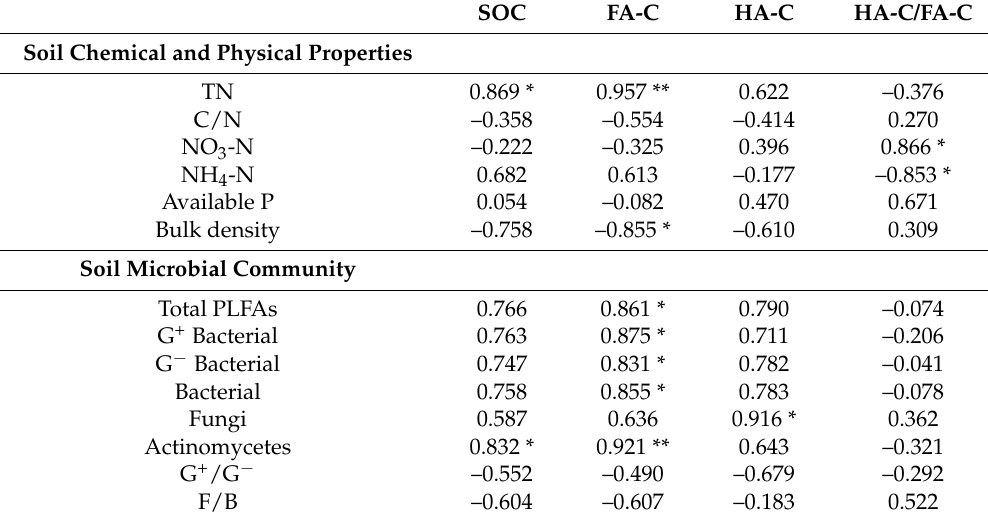
Table 4. Correlation coefficient ( r ) matrix between soil microbial groups and indicators of soil chemistry and carbon